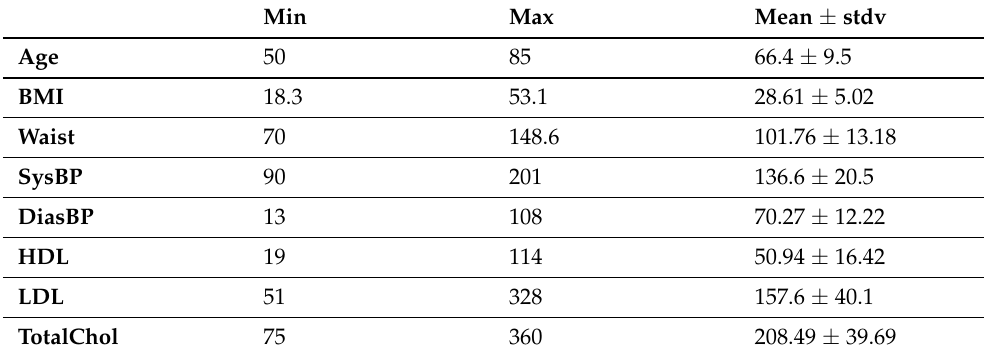
Table 1. Statistical Description of the Numerical Features in the Balanced Dataset.